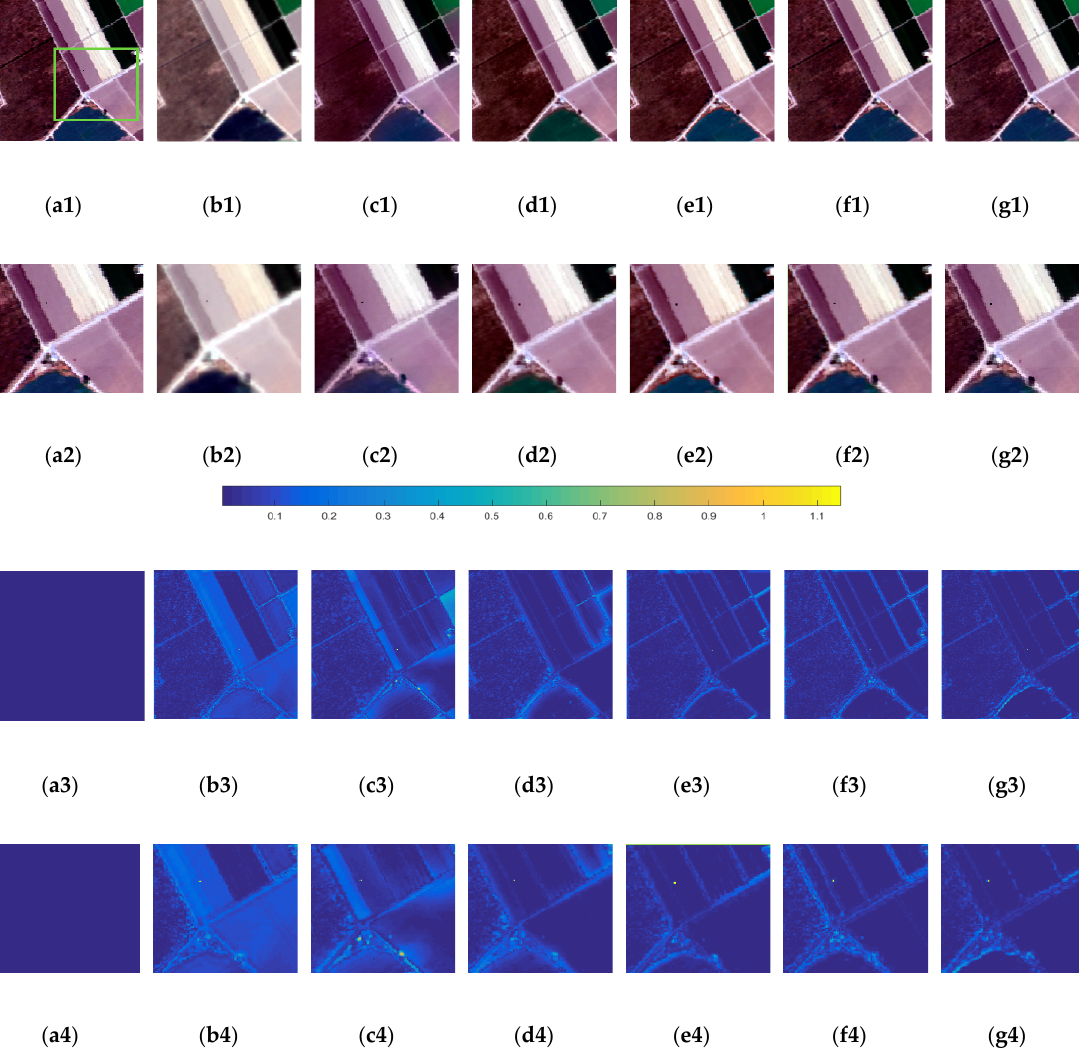
Figure 6. Experimental results obtained by each method for the Salinas scene dataset. ( a1 – a4 ) Reference image; ( b1 – 4 ) GS; ( c1 – 4 ) GFPCA; ( d1 – 4 ) CNMF; ( e1 – 4 ) HySure; ( f1 – 4 ) Bayesian; ( g1 – 4 ) HFWT. (First